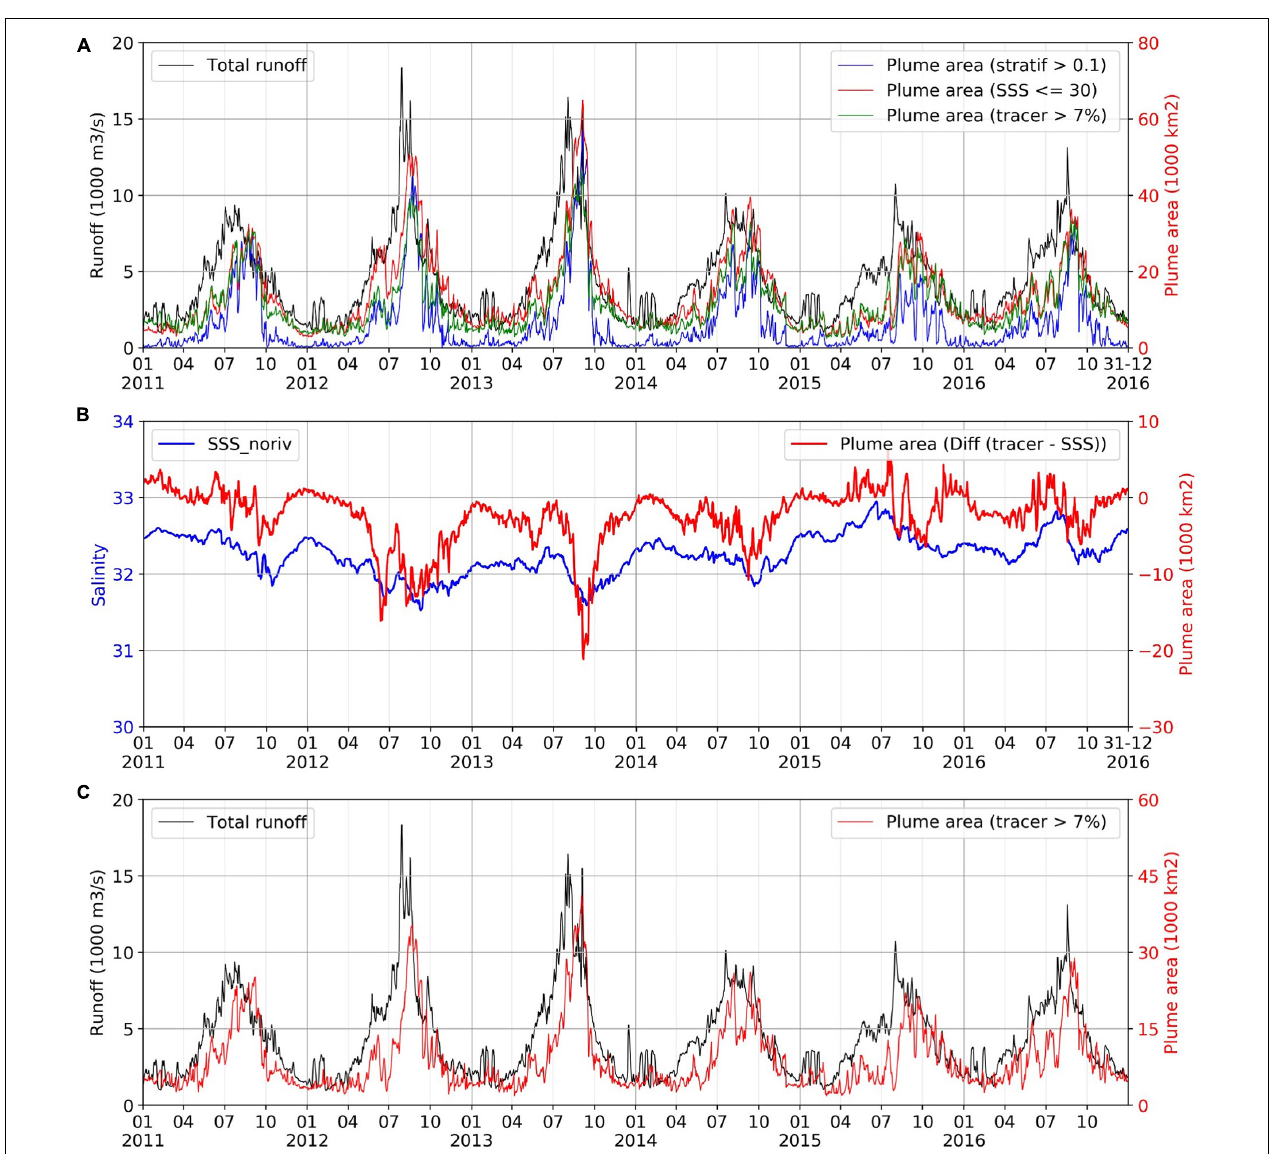
FIGURE 8 | (A) Total runoff (in m 3 /s) and plume area (in km 2 ) for all the rivers in the Gulf of Tonkin. The plume area is calculated using the Stratification Index (blue), SSS (red) and tracer concentration (green). (B) Spatially averaged SSS over the whole domain (in blue) from the simulation without river (GOT_NORIV), and difference of river plume area between SSS and tracer methods (in red). (C) Daily runoff and plume area for the Red River and Southern